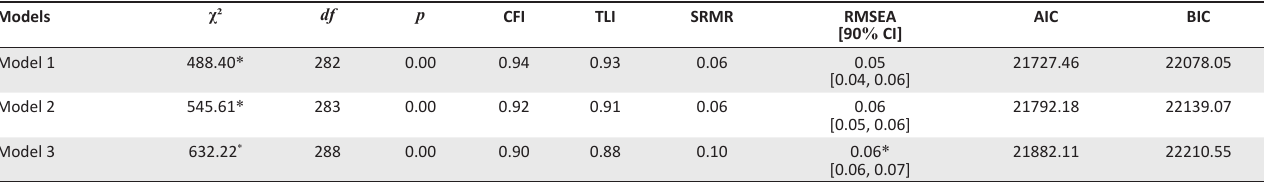
TABLE 4: Competing structural models.